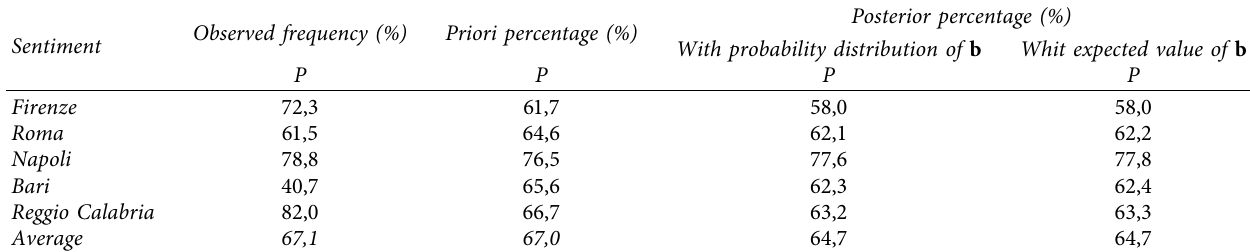
Table 5: Elasticity evaluation adopting the posterior parameters for the Italian metropolitan cities considered.